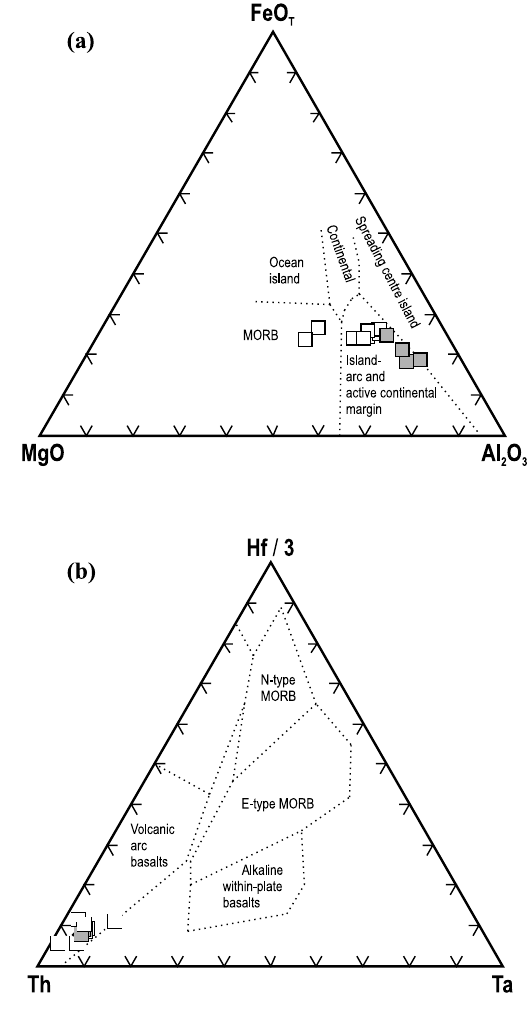
Fig. 8 – Major and trace element plots for geotectonic